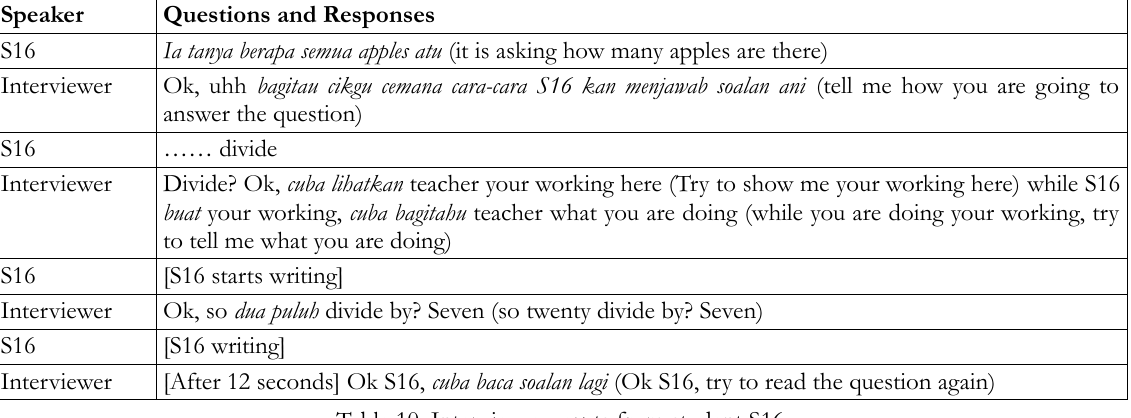
Table 10. Interview excerpts from student S16